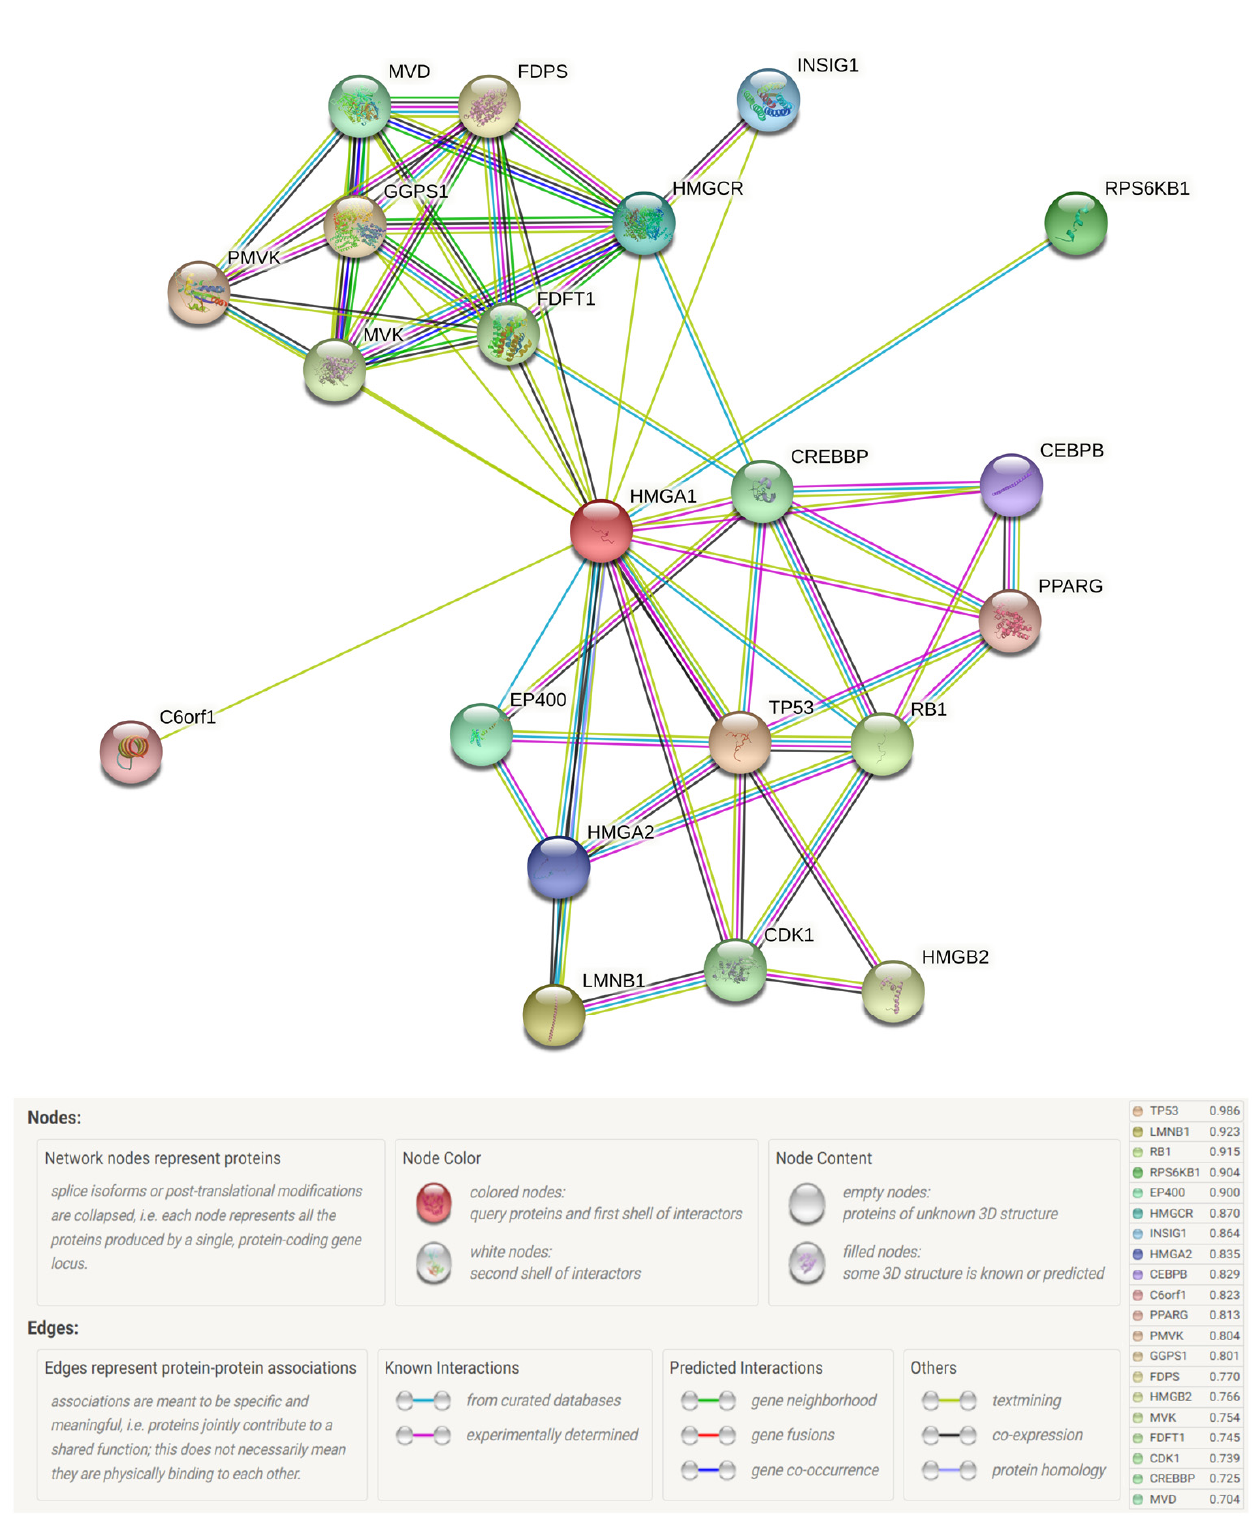
Figure 15. The protein interaction network of the HMGA1 gained from the STRING database.